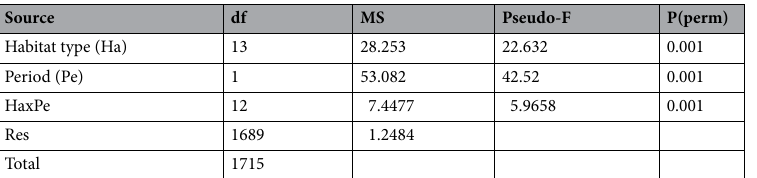
Table 5. PERMANOVA table of results: comparison of taxa richness of juvenile assemblages between habitats and periods. Table gives degrees of freedom (df), Mean Squares (MS), calculated pseudo-F, and P-values (P). P-values were obtained by 999 permutations of residuals under a reduced model (perm) or through Monte Carlo test (MC, see “Material and methods”).